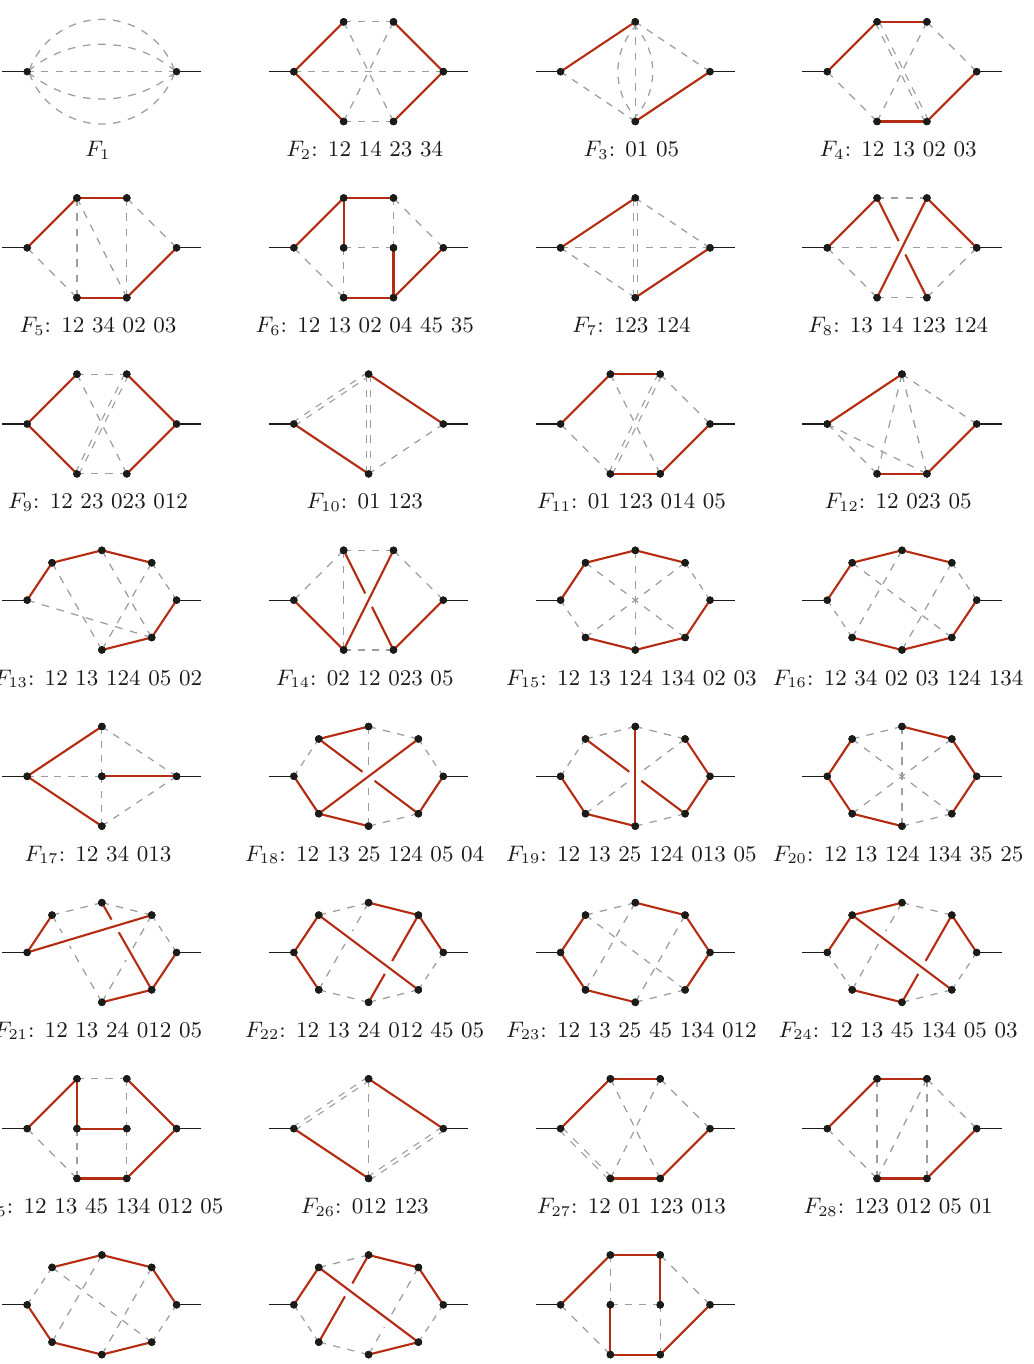
Table 1 . Cut diagrams for five-particle phase-space master integrals in QCD. Dashed lines rep- resent cut propagators and carry final-state momenta p 1 , . . . , p 5 . Labels represent propagators, so that “123” corresponds to p 1 + p 2 + p 3 and ”012” to q − p 1 − p 2 (where q is the initial-state momentum, i.e., q = p 1 + · · · + p 5